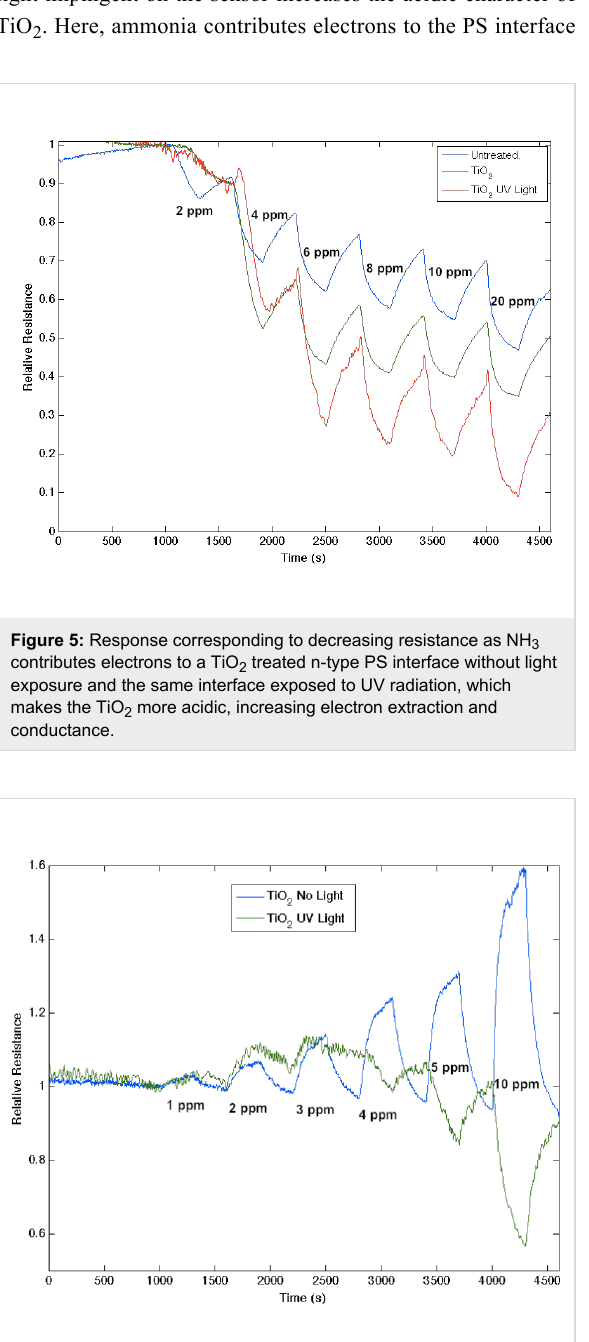
Figure 7: Response corresponding to decreasing resistance as a significant TiO 2 − x N x fractional nanostructure deposition leads to the extraction of electrons from the moderate acid NO 2 for all but the highest NO 2 concentrations (blue). The efficiency of electron extrac- tion is less than that of TiO 2 at a similar concentration. Response corresponding to a substantially greater decrease in resistance upon white-light exposure